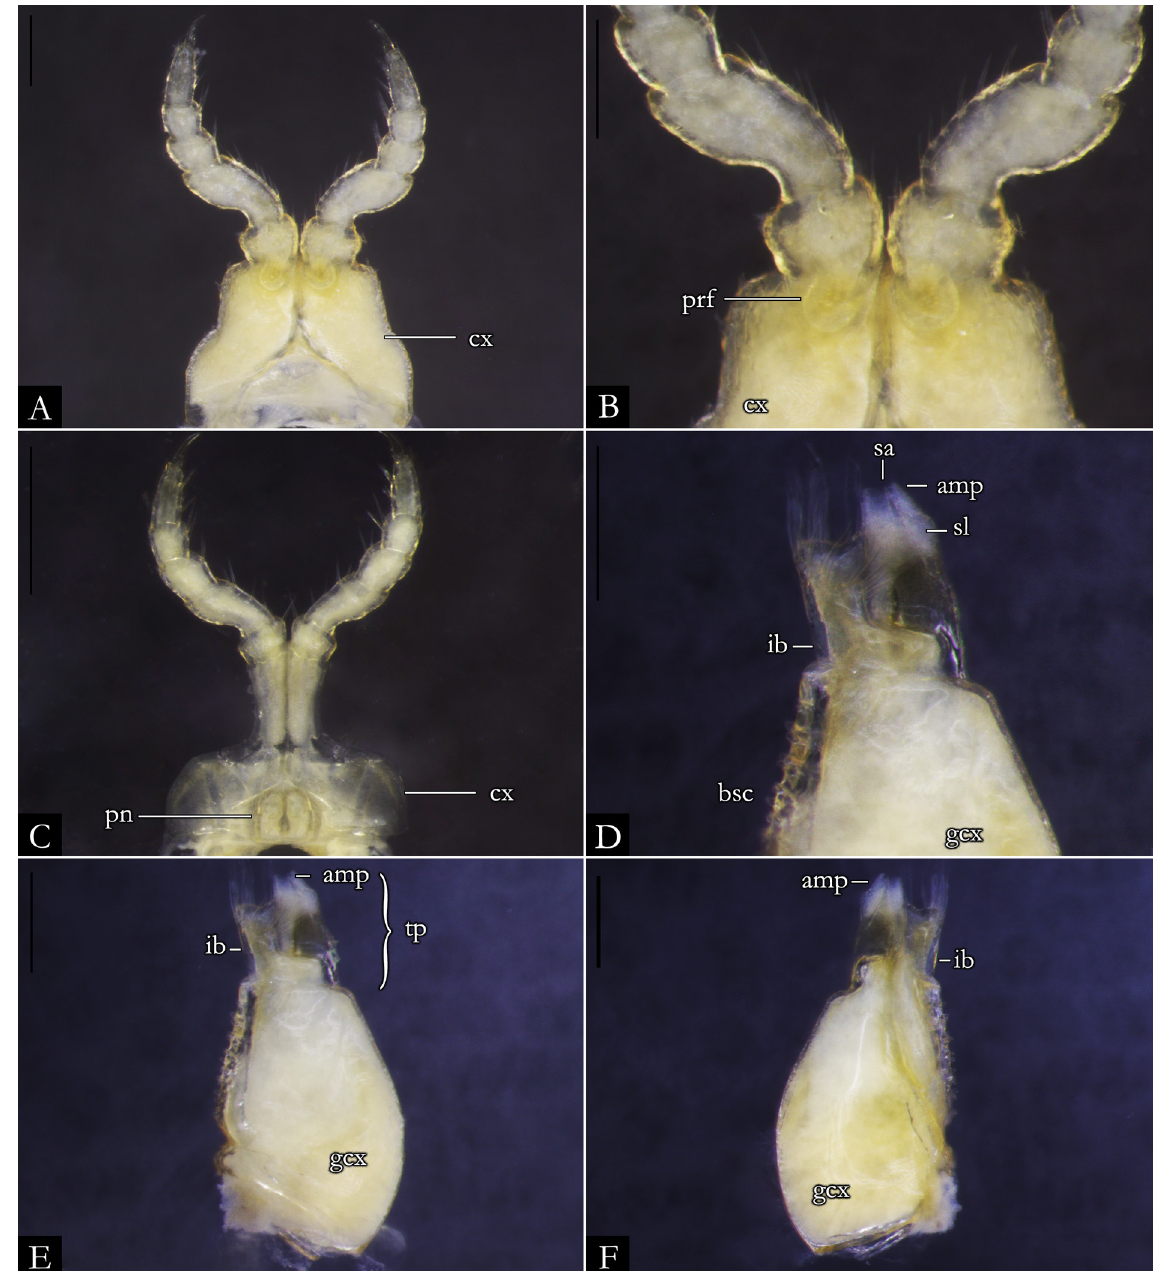
Fig. 79. Pseudonannolene leucocephalus Schubart, 1944, ♂ (MZSP 1060). A . First leg-pair. B . Detail of prefemur. C . Second leg-pair. D . Detail of telopodite, in anal view. E . Left gonopod, in anal view. F . Left gonopod, in oral view. Abbreviations: see Material and methods. Scale bars = 0.2